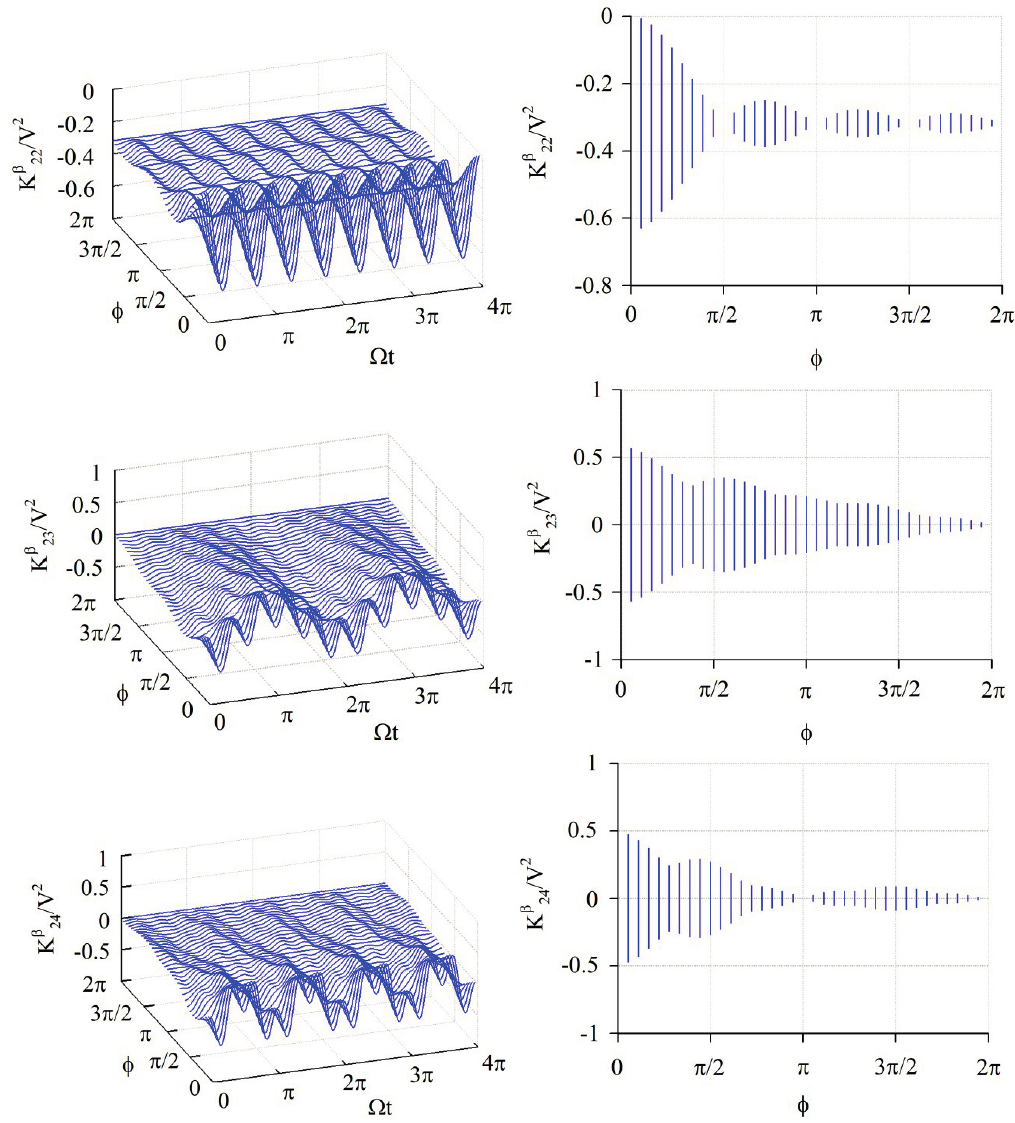
Figure 4. The numerical results of some feature elements ( of the β -partition of stiffness matrix. The graphs at the right-hand side are the projections of the graphs at the left-hand side on the plane containing ϕ -axis and K